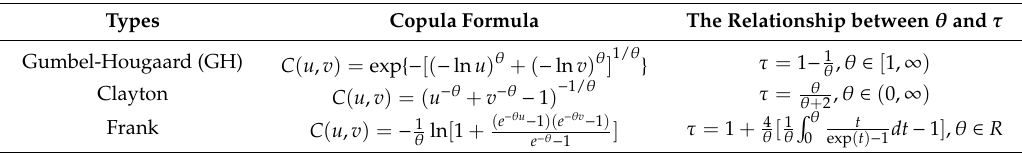
Table 1. Several types of the two-dimensional Archimedean Copula